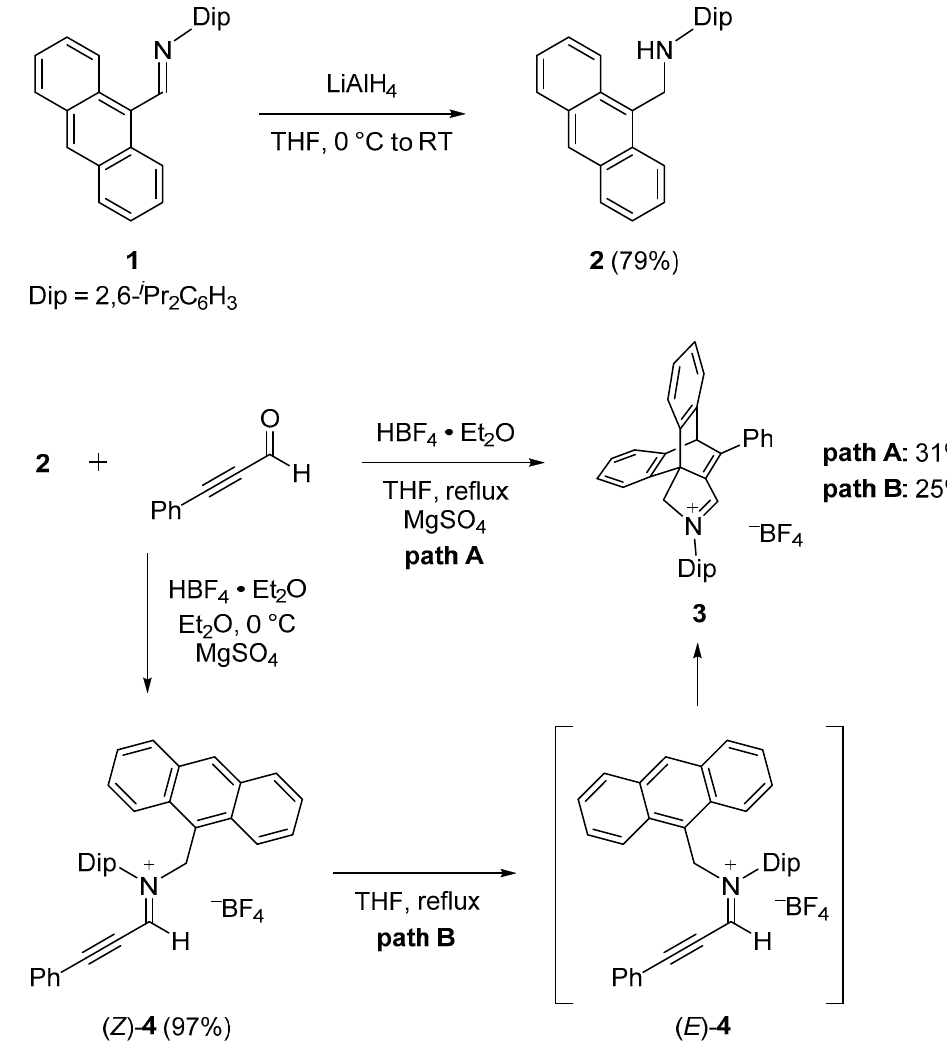
Figure 1. 1,4-diaryl-1,3-butadiene derivatives bearing a rigid dibenzobarrelene